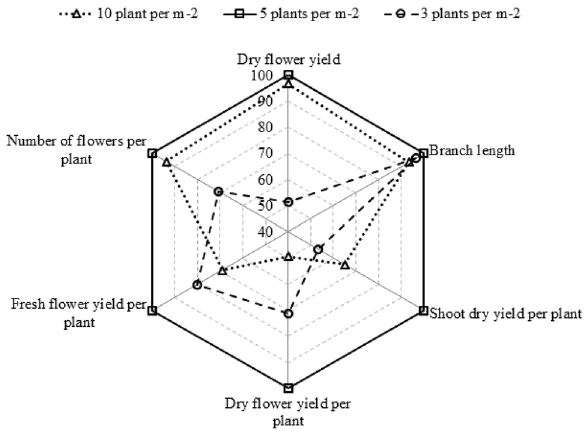
Figure 1. Relative comparison of Echium amoenum growth characteristics under three plant densities: 5 plants per m −2 (continuous line), 10 plants per m −2 (dotted line), and 3 plants per m −2 (cut line).